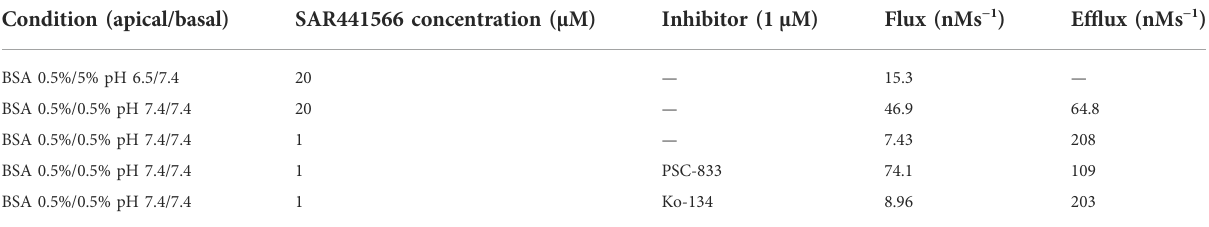
TABLE 3 Transport characterization of SAR441566 in Caco-2